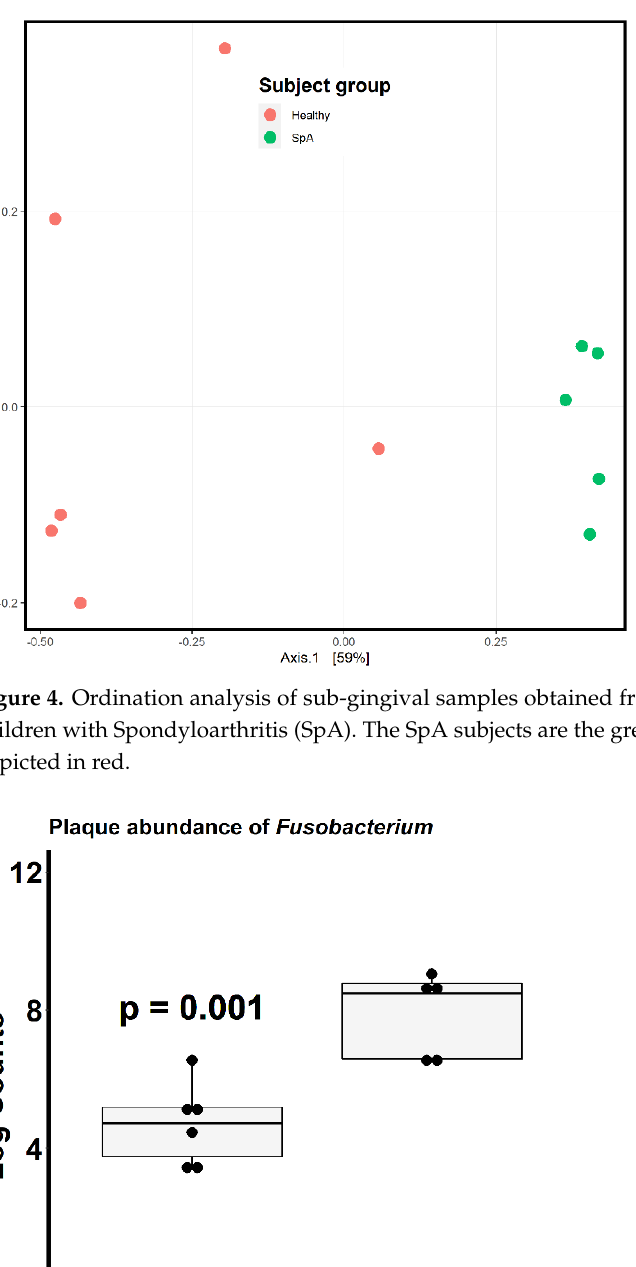
Figure 3. Ordination analysis of sub-gingival and salivary samples obtained from healthy control subjects and children with Spondyloarthritis. A negative control (blank) is included as well. The shape of the dot indicates the habitat (circle, blank specimen; triangle, plaque; square, saliva), while the color of the specimen indicates the subject group (blue, blank specimen; green, Spondyloarthri- tis; red, Healthy controls).